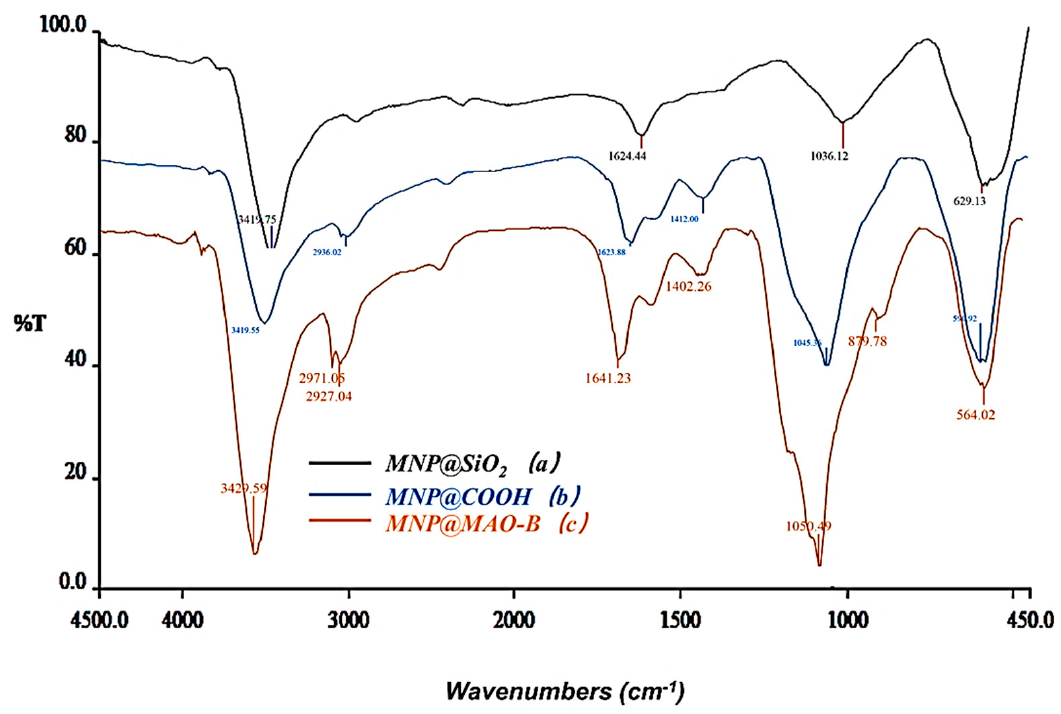
Figure 1. FT - IR spectra of ( a ) MNPs@SiO 2; ( b ) MNPs@COOH; ( c ) MNPs@MAO - B. Figure 1. FT- IR spectra of ( a ) MNPs@SiO 2 ; ( b ) MNPs@COOH; ( c )